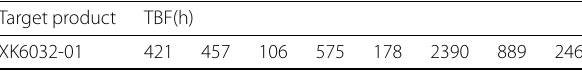
Table 1 Fault data during actual operation